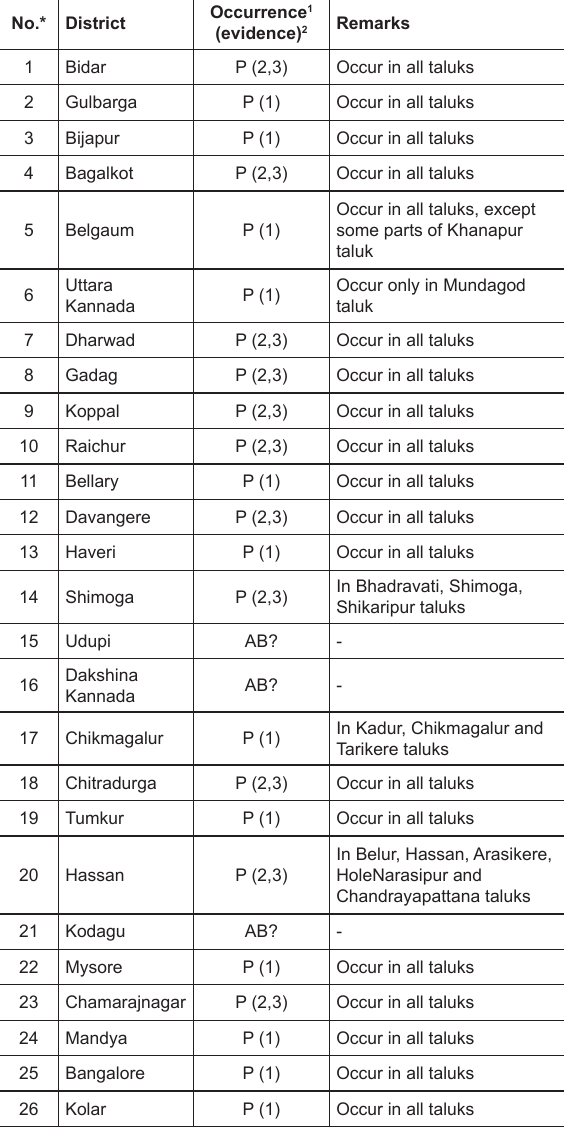
Table 1. Occurrence of the Indian Fox in different districts of Karnataka No.*